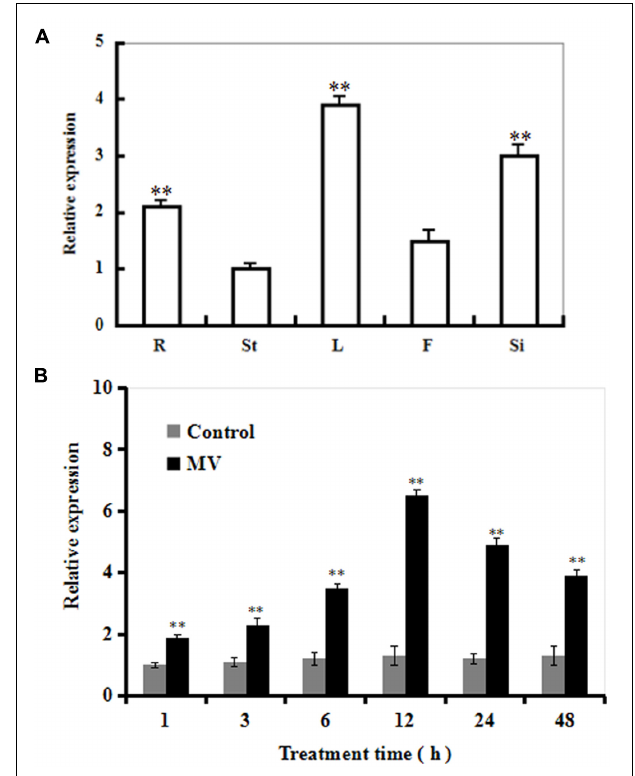
FIGURE 1 | The transcript profiles of SiR in Arabidopsis organs and during oxidative stress. (A) The transcriptional pattern of SiR in Arabidopsis root (R), stem (St), leaf (L), flowers (F), and immature silique (Si) samples evaluated by qRT-PCR. (B) Changes in the SiR transcript levels at various time points in response to MV exposure in Arabidopsis plants by qRT-PCR. Three-week-old plants were exposed to H 2 O (control) or 10 µ M MV and sampled at 1, 3, 6, 12, 24 and 48 h. Leaf samples were collected for qRT-PCR analysis. In both (A,B) , Actin2 was used as an internal control. For each experiment, three technical replicates were conducted. Data shown are Mean ± SE of three independent experiments. ∗∗ t -test, with P < 0.01.